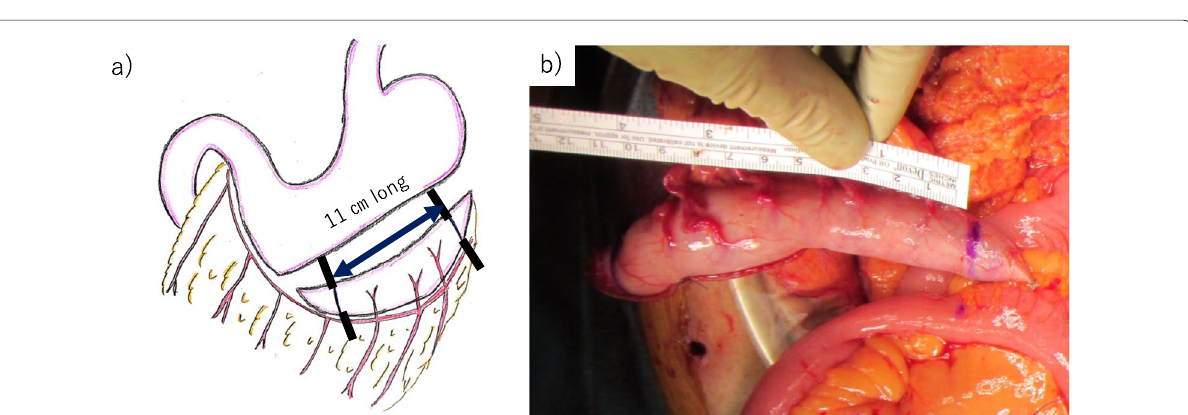
Fig. 5 Creation of gastric conduit a Both ends were trimmed, and the gastric conduit was 11 cm long. b The gastric conduit was 11 cm in